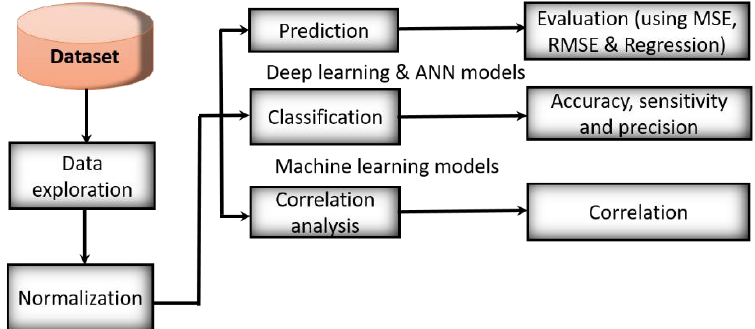
Figure 9. A framework for the application of AI for water quality monitoring [90].